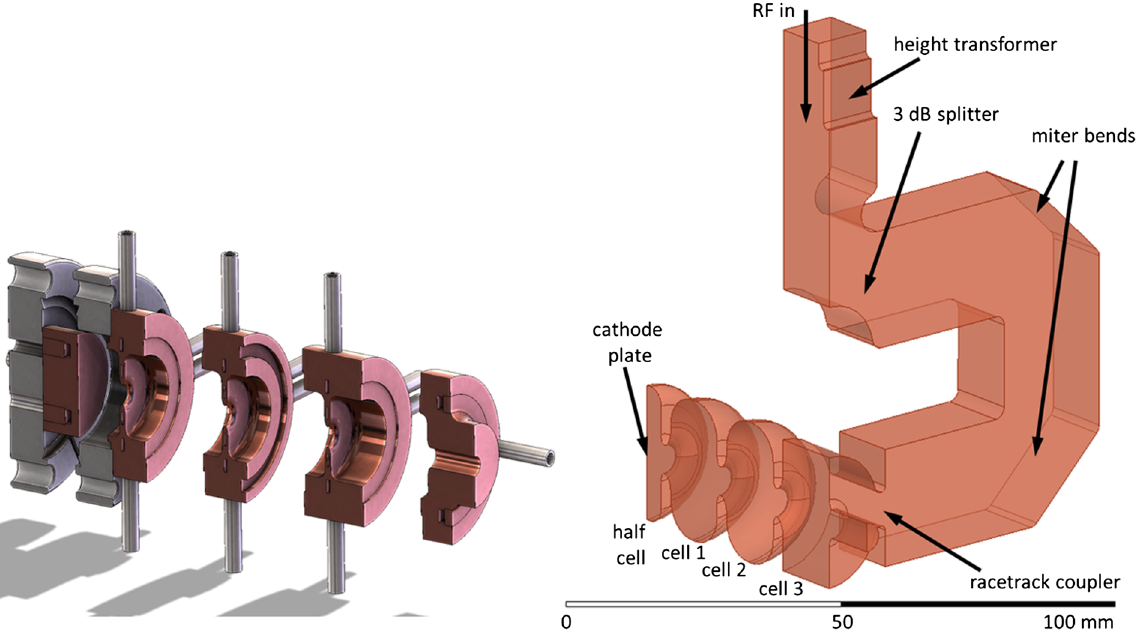
FIG. 19. The left side shows assembly of photoinjector cells including extensive cooling channels needed for 3 kW heat load. The right side shows a CAD model of the 3.5 cell cavity with coupling and waveguide. The final cell acts as a coupling